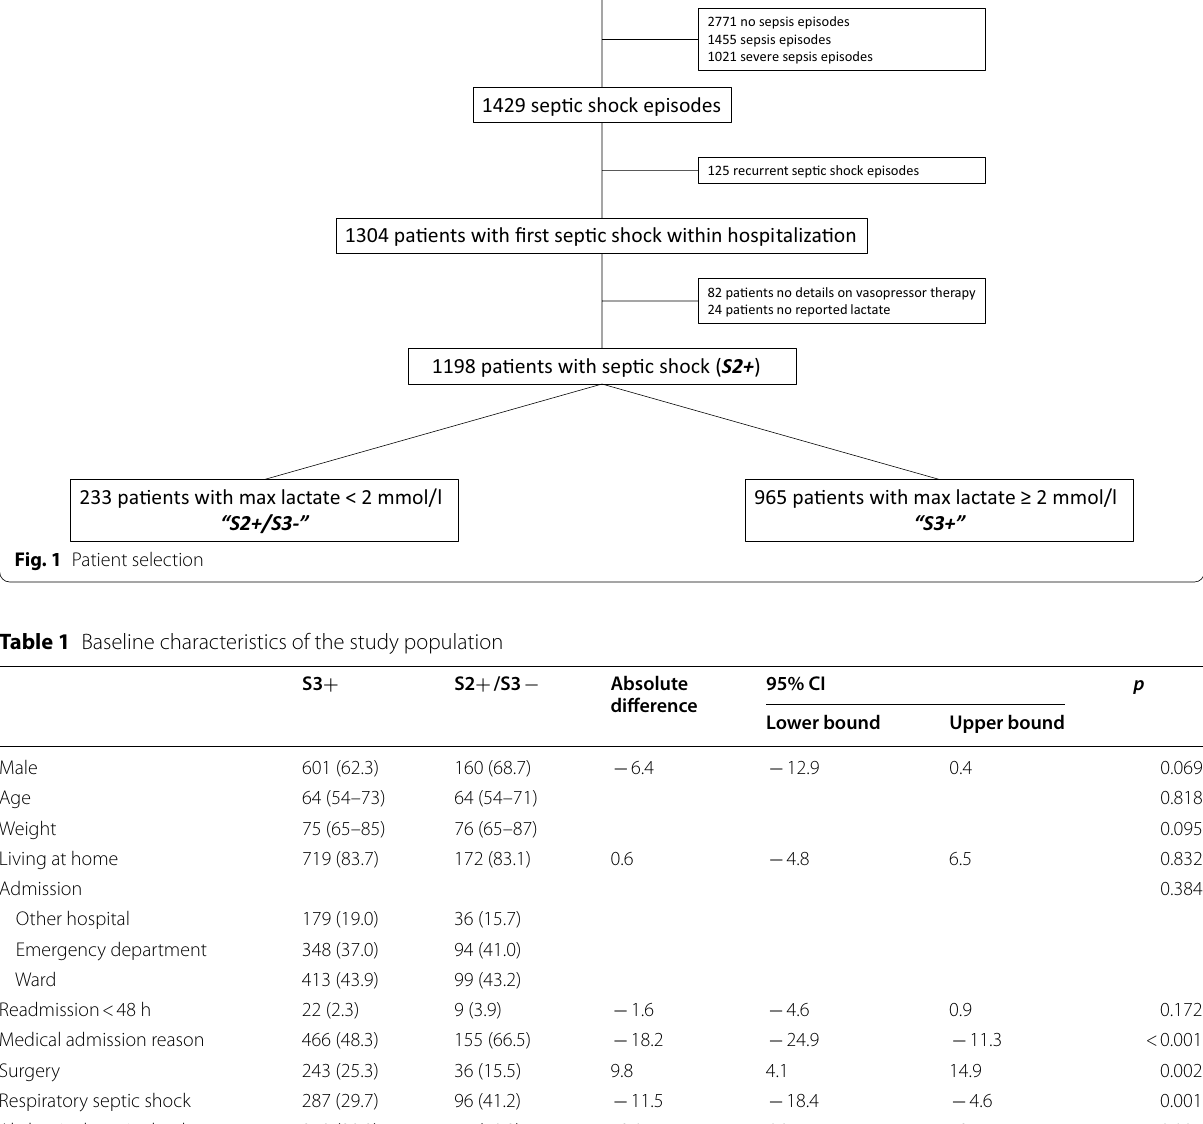
All values are expressed as median (interquartile range) or n (%). Absolute differences are reported for